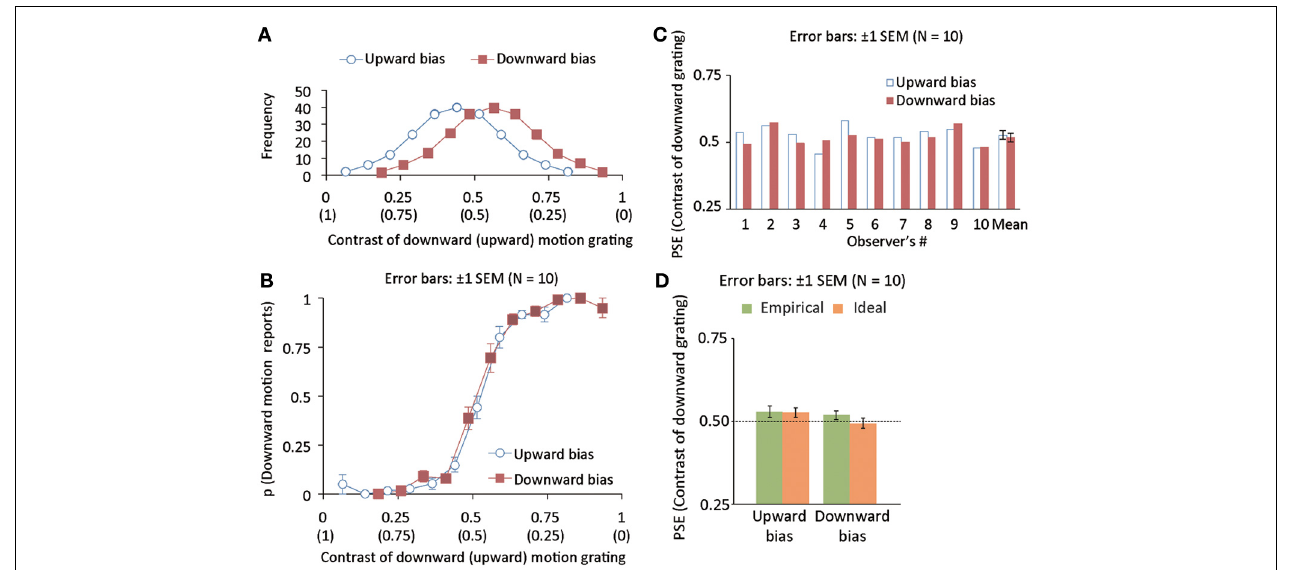
FIGURE 3 | (A) Distributions of luminance contrast for downward (and upward) drifting gratings in upward (blue, open disk maskers) and downward (red, open square markers) bias conditions. The mean of the distribution is deviated from 0.5 by 0.06 negatively and positively for upward- and downward-bias conditions. The standard deviation of the